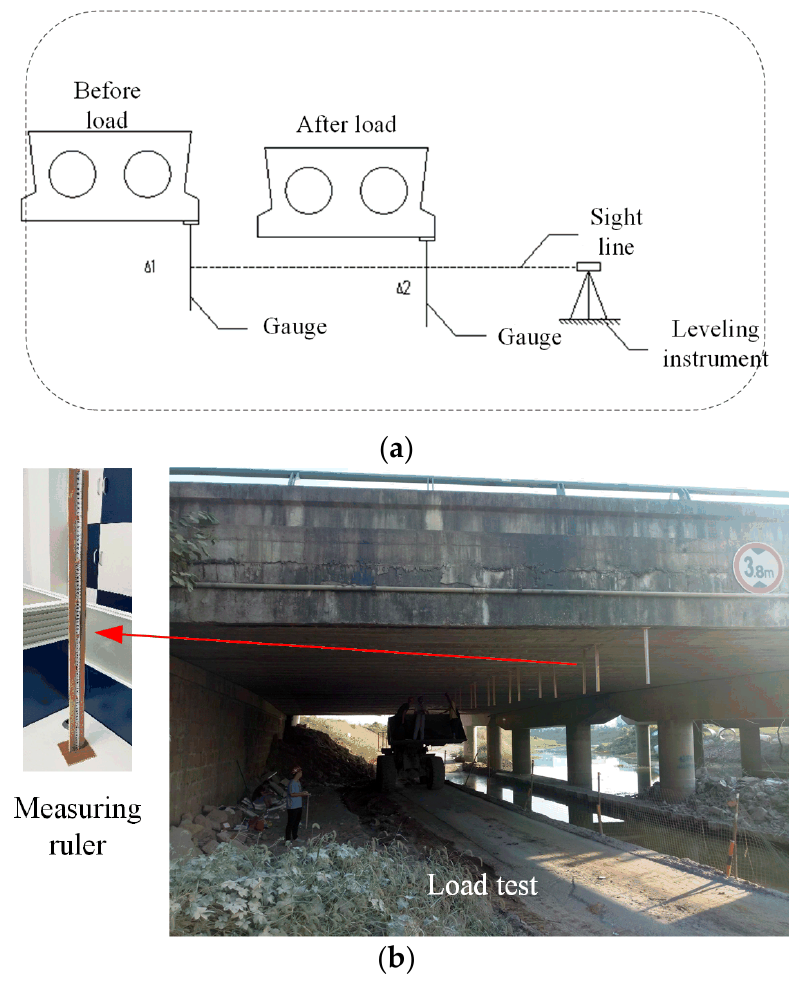
Figure 3. Measurement based on the gauges and leveling instrument: ( a ) diagram; ( b ) installation of measuring rulers.